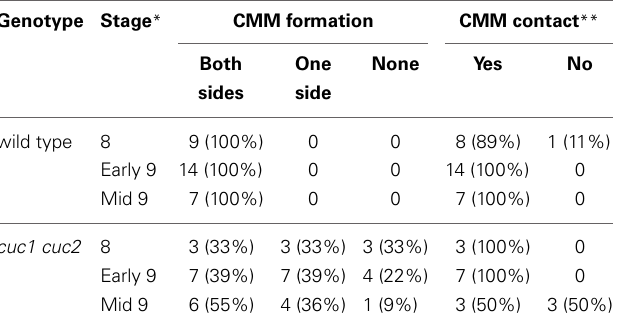
Table 1 | Effect of cuc1 cuc2 on CMM